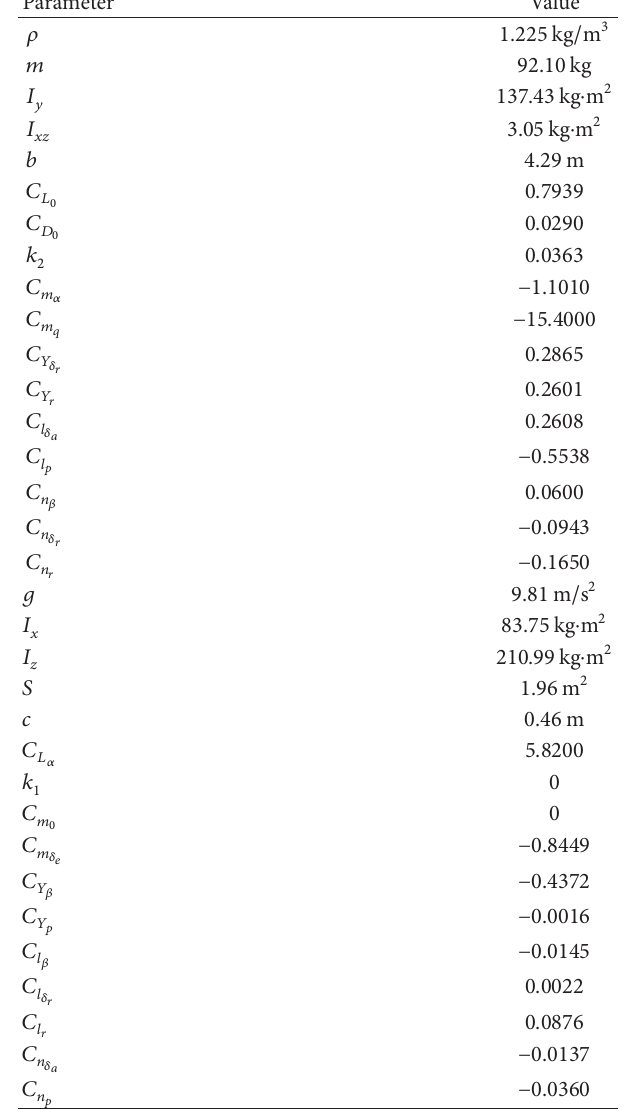
Table 1: Parameters for the Lambda UAV landing at sea level